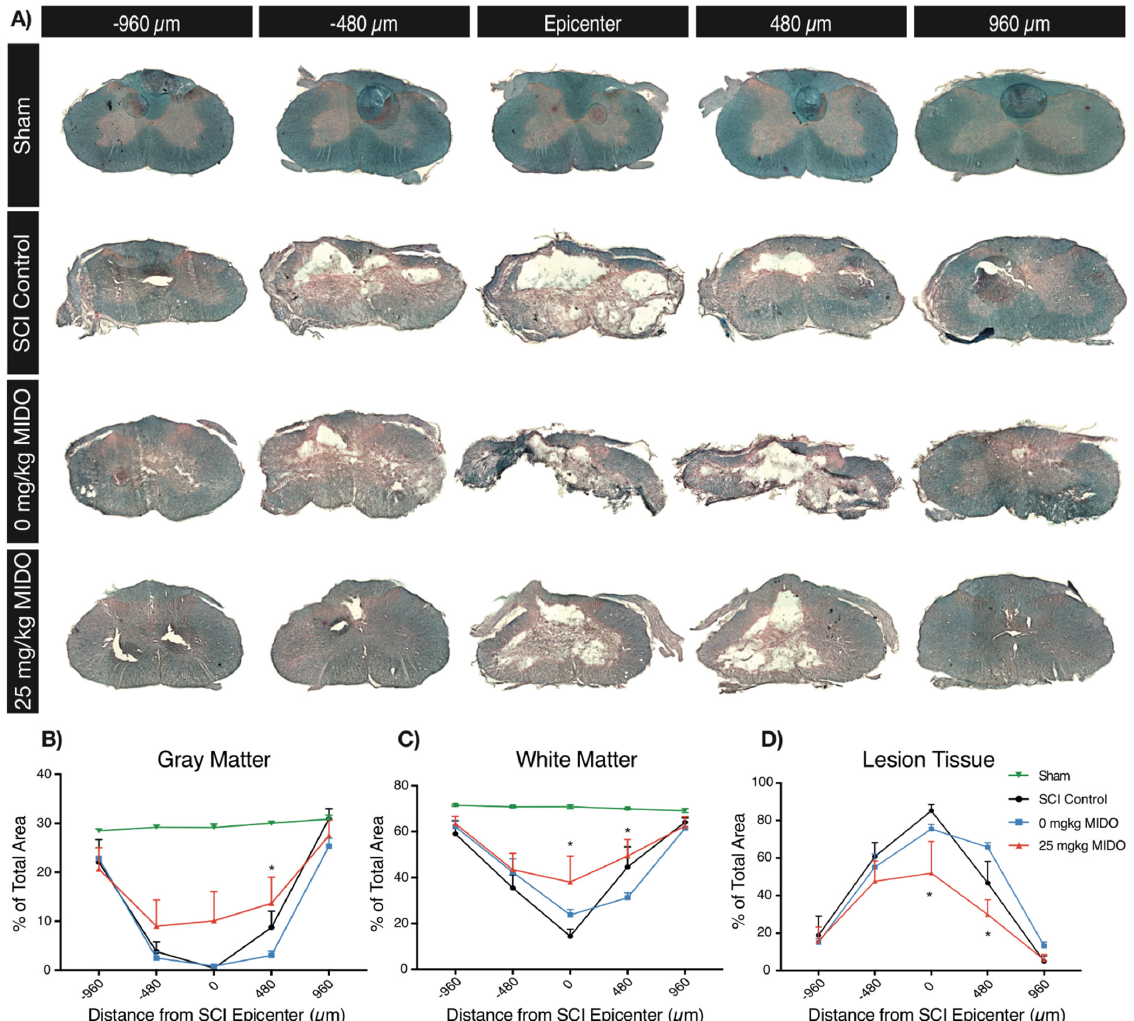
Figure 5. LFB and H&E staining revealed increased tissue preservation in both gray and white matter at 8 weeks post-SCI ( n = 5 per cohort). ( A ) Representative images show the injury epicenter, as well as 480 and 960 µm rostral and caudal to the injury epicenter in the sham, SCI control, 0 mg/kg midostaurin, and 25 mg/kg midostaurin cohorts. ( B ) There was a significant difference in gray matter volume in all injured groups compared uninjured shams. Animals receiving 25 mg/kg midostaurin demonstrated improved gray matter preservation. ( C ) The injury reduced white matter volume, and 25 mg/kg midostaurin enhanced white matter preservation. ( D ) The lesioned tissue size was reduced in the 25 mg/kg midostaurin-treated group. Data are presented as mean ± SEM values and were assessed using two-way ANOVA with FDR according to the two-stage linear set-up procedure of Benjamini, Krieger, and Yekutieli to correct for multiple comparisons (*: p < 0.05).